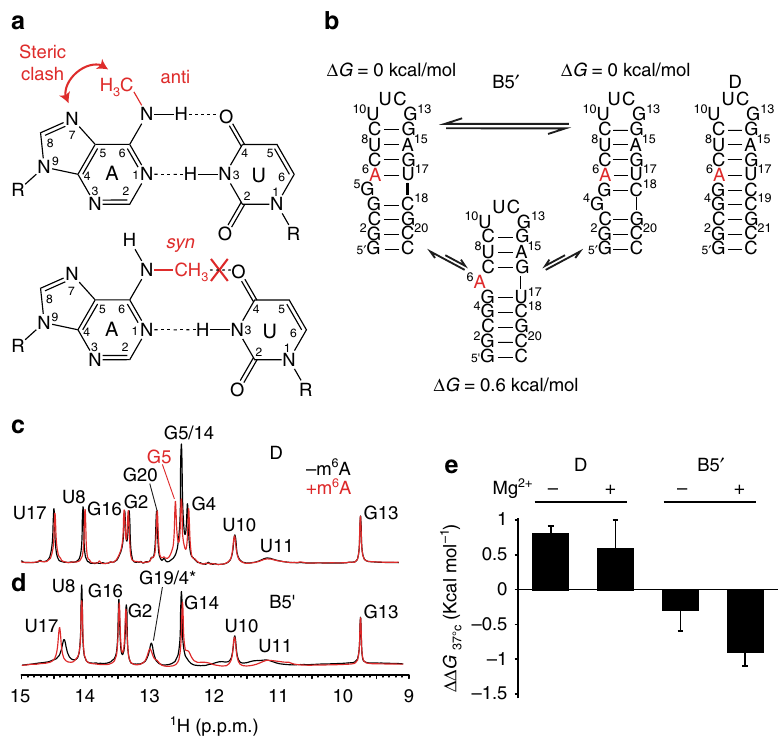
Fig. 1 m 6 A stabilizes junctional A – U base pairs with 5 ʹ bulge. a The methyl group in m 6 A destabilizes A – U pairing through steric contacts. b Design of an m 6 A-dependent RNA structural switch. Secondary structures and free energies computed using the MC-Fold web server 39 . The modi fi ed adenine (A6) is highlighted in red. c , d Comparison of 1 H NMR spectra of unmodi fi ed and m 6 A6 substituted ( c ) D and ( d ) B5 ʹ recorded in 15 mM sodium phosphate, 25 mM NaCl, 0.1 mM EDTA and 3 mM Mg 2 + at pH 6.4 and 10 °C. e Impact of methylation on the thermal stability of the hairpins with and without 3 mM Mg 2 + . Shown are the differences in the free energy of melting between methylated and unmodi fi ed RNA, i.e., ΔΔ G = Δ G (methylated) − Δ G (unmodi fi ed). The uncertainty re fl ects the standard deviation from at least three measurements (see Supplementary Table